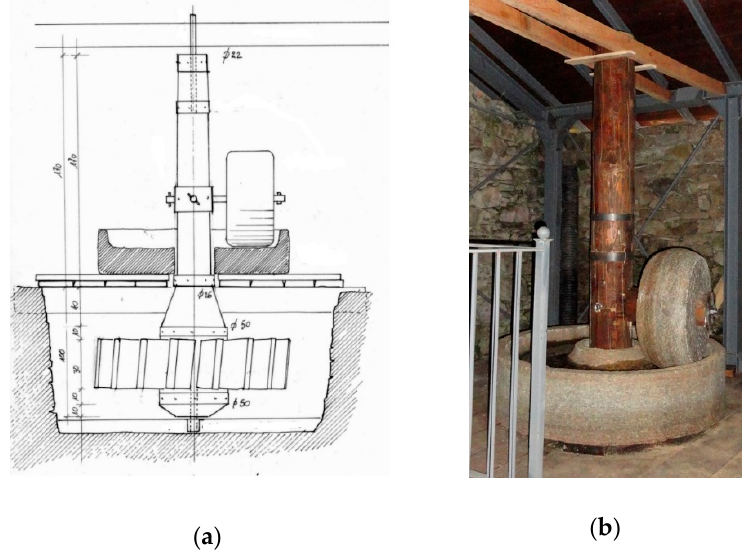
Figure 1. Hemp roller mill of Combe, Celle Macra (Italy). ( a ) Scheme of the horizontal wheel keyed to the vertical shaft; ( b ) the mill after the renovation. Courtesy of Arch. Roberto Olivero.